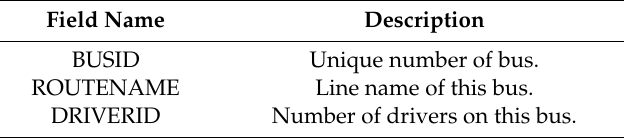
Table 3. Data structure of schedule table.